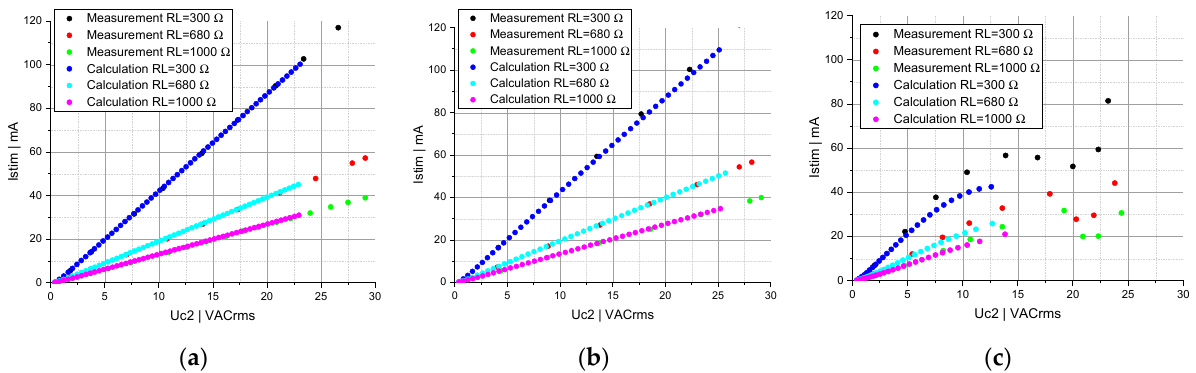
Figure 10. Stimulation current Istim as a function of the induced voltage Uc2 for a circuit topology of four parallel-connected capacitors consisting of: ( a ) four linear capacitors; ( b ) two linear and two nonlinear capacitors; ( c ) four nonlinear capacitors. The measurements (black, red, green) and calculations (blue, cyan, magenta) were performed for R L = 300 Ω , 680 Ω and 1000 Ω , respectively.